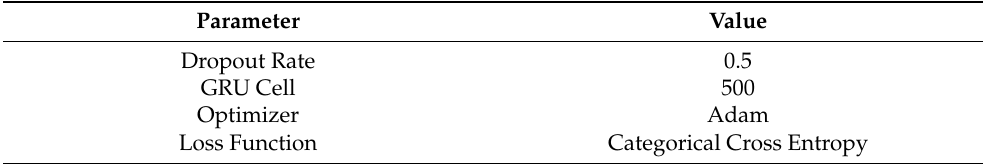
Figure 7. Architecture of the image caption: ( a ) LSTM version; and ( b ) Enhanced GRU version. Table 2. Parameter settings of Image caption.